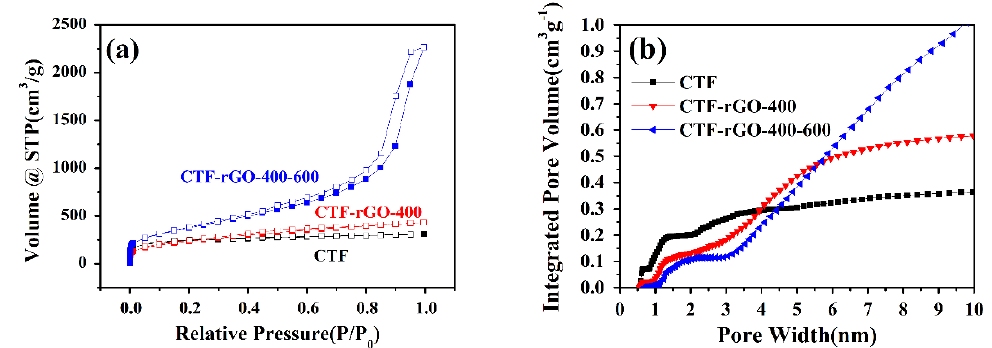
Figure 3. ( a ) Nitrogen sorption isotherms (solid and hollow squares correspond to the adsorption and desorption process respectively) and ( b ) the plot of cumulative pore volume vs. pore width of the CTF, CTF-rGO-400, and CTF-rGO-400-600.